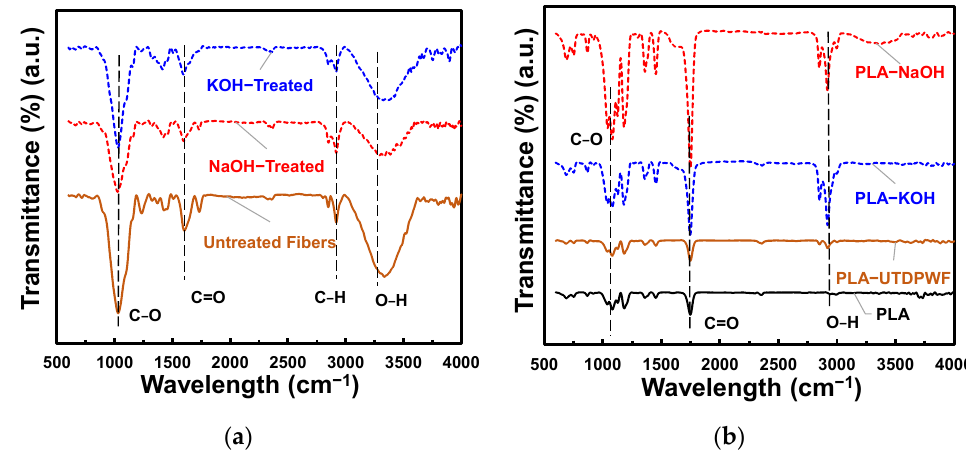
Figure 1. ( a ) FTIR of treated and untreated fibers; ( b ) FTIR of neat PLA, PLA-UTDPWF, PLA-NaOH, and PLA-KOH composites.